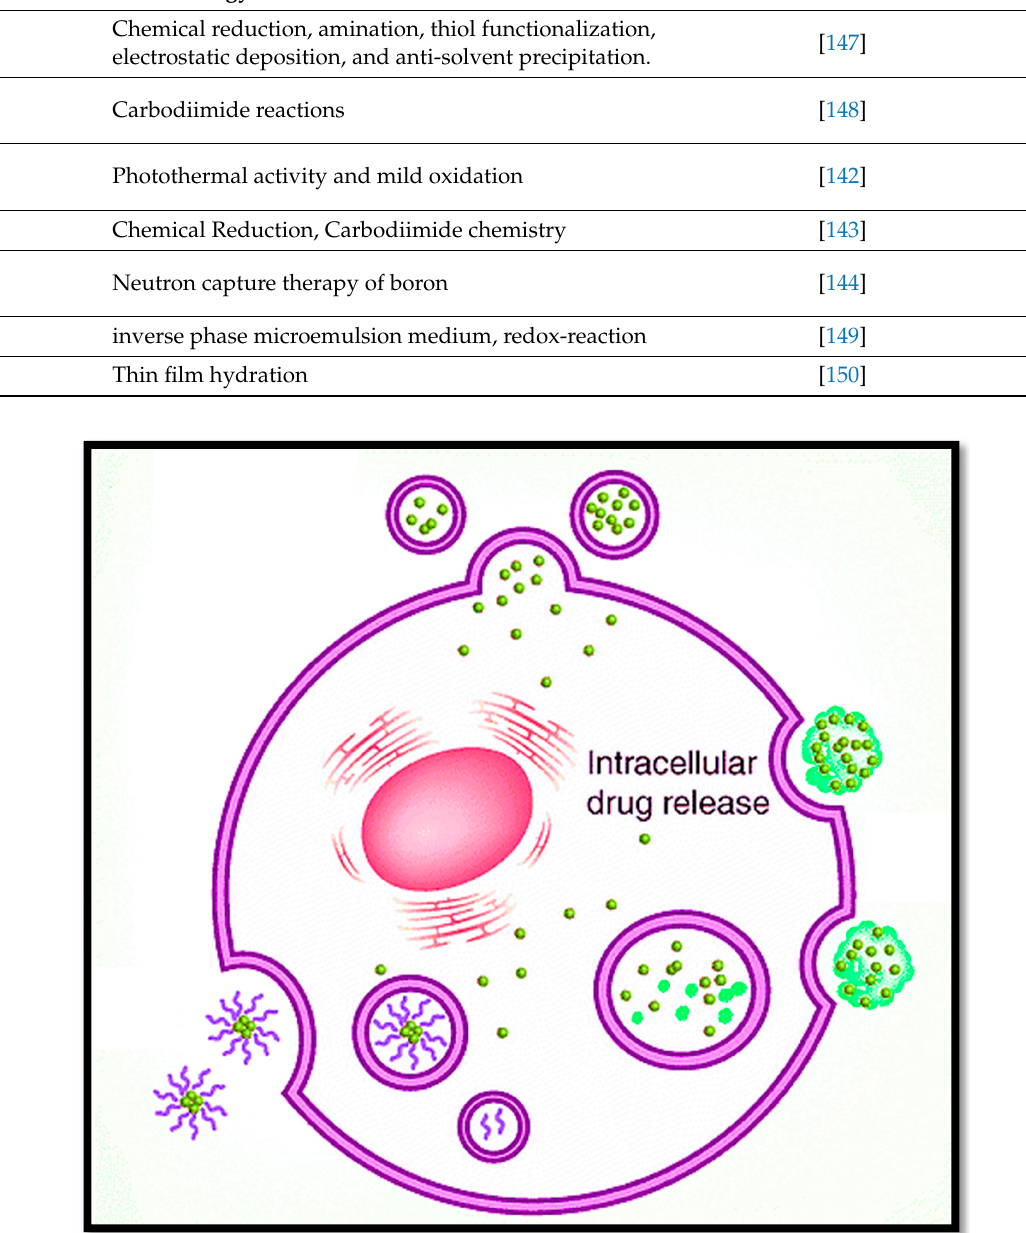
Figure 4. Multi-functionalized nanocarriers release the drug in a specific environment inside the tumor for targeted intracellular drug release. Table 1. Summary of multi-functionalized nanocarriers in treatment of BC.